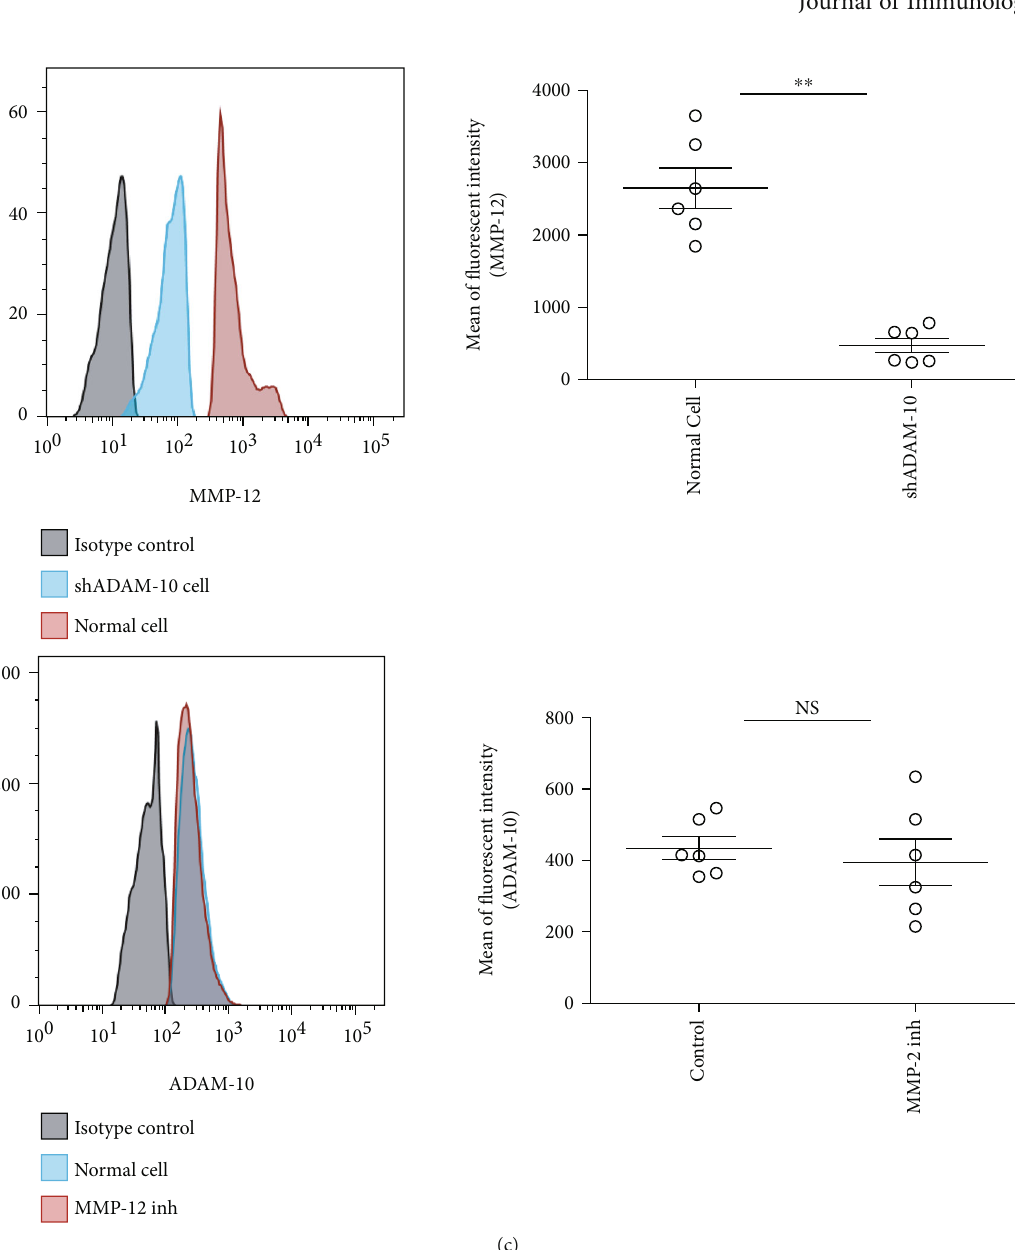
Figure 3: Interfered A disintegrin and metalloprotease 10 (sh ADAM-10) decreases lipopolysaccharide-promoted proliferation- (LPS-) induced macrophage activation via matrix metalloproteinase 12 (MMP-12) downregulation. (a) The e ff ect of LPS and MMP-12 inhibitors on sh ADAM-10 RAW246.7 and sh ADAM-10 J774a.1 cell viability. Each group contained six samples. (b) Real-time qualitative PCR (RT-qPCR) analysis of ADAM-10 and MMP-12 transcription levels in response to LPS and MMP-12 inhibitors in sh ADAM-10 RAW246.7 cells. Each group contained six samples. (c) Flow cytometry analysis shows inhibition of ADAM-10 decreased MMP-12 expression, while inhibition of MM-12 has no signi fi cant e ff ect on